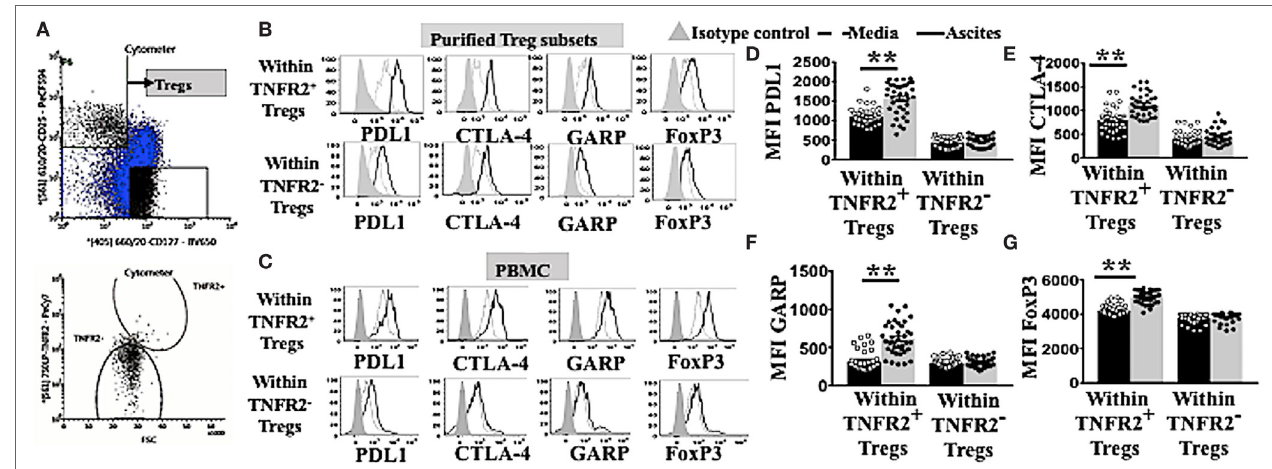
FigUre 3 | TNFR2 + regulatory T cells (Tregs) conditioned in ascites expressed higher levels of functional immunosuppressive molecules, such as programmed cell death ligand-1 (PD-L1), CTLA-4, and GARP. (a) Peripheral blood mononuclear cells (PBMCs) from two healthy donors were isolated by Ficoll density centrifugation and labelled with anti-CD3, CD4, CD25. CD127 and tumor necrosis factor receptor 2 (TNFR2) and flow cytometric cell sorting was performed. (a) Tregs were identified by gating on CD3* CD4* population, followed by CD127 and CD25 to identity CD25 hi CD127 lo . Two populations of Tregs were sorted by gating on TNFR2 + and TNFR2 − . Isolated Tregs subsets were cultured in either complete AIM V media or in cell-free ascites for 48 h. Cells were washed and labeled with anti-CD3, CD4. CD25, PD-L1, CTLA-4. GARP and FoxP3 and prepared for flow cytometric analysis. (c–g) PBMCs from healthy donors ( n = 30) were incubated in either AIM V media or ascites supernatant from an advanced epithelial ovarian cancer patient for 48 h. Cells were washed, stained for anti-CD3, CD4, CD25, TNFR2. PD-L1, CTLA-4, GARP, and FoxP3, and prepared for flow cytometric analysis. (c,B) Expression of PD-LI, CTLA-4, GARP, and FoxP3 expression were analyzed in sorted TNFR2 + Tregs and TNFR2 − Tregs, (B) and in Tregs from PBMCs by gating on Tregs TNFR2 + and Tregs TNFR2 − cells incubated in media (dashed line) and ascites (solid line). The shaded histogram represents staining with an isotype control. (D–g) The level of expression (in MFI) PD-L1, CTLA-4, GARP, and FoxP3 within Tregs TNFR2 + and Tregs TNFR2 − cells incubated in media (black bar) and ascites (gray bar) ( n = 30). * p < 0.05 and ** p < 0.0001, Wilcoxon matched-pair t -test. Data using PBMCs were pooled from three independent experiments (error bars-SEM), while data of sorted cells are replicates of two